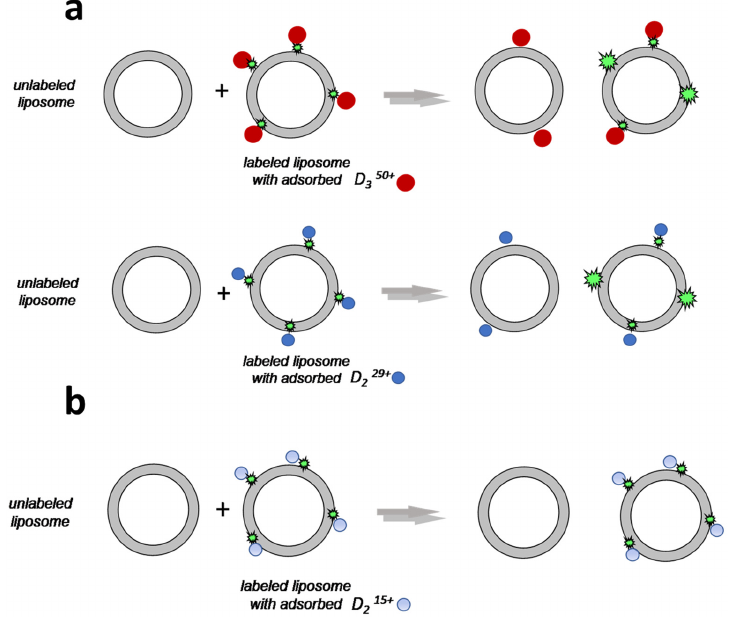
Figure 9. Schematic representation of the migration experiment for D 350+ and D 229+ ( a ), as well as for D 215+ ( b ). D 350+ and D 229+ were able to migrate between liposomes since the binding was due to electrostatic forces ( a ). For D 215+ , hydrophobic interactions were observed, along with electrostatic complexation; as a result, defects were formed in the membrane that led to irreversible interactions with no migration of D 215+ between liposomes ( b ). The dendrimer molecules are indicated as circles, and the fluorescent labels are indicated as green stars.